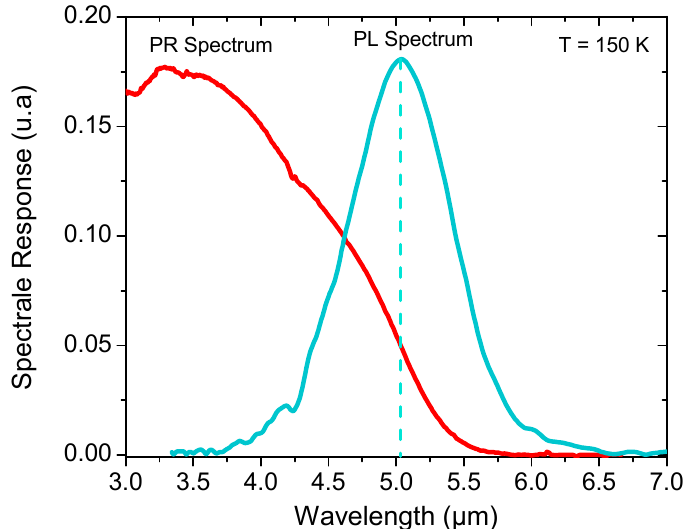
Figure 4. InAsSb/InAs T2SL structure: photo-response (PR) spectrum at − 400 mV and photolumi- nescence (PL) measurement performed at 150 K.